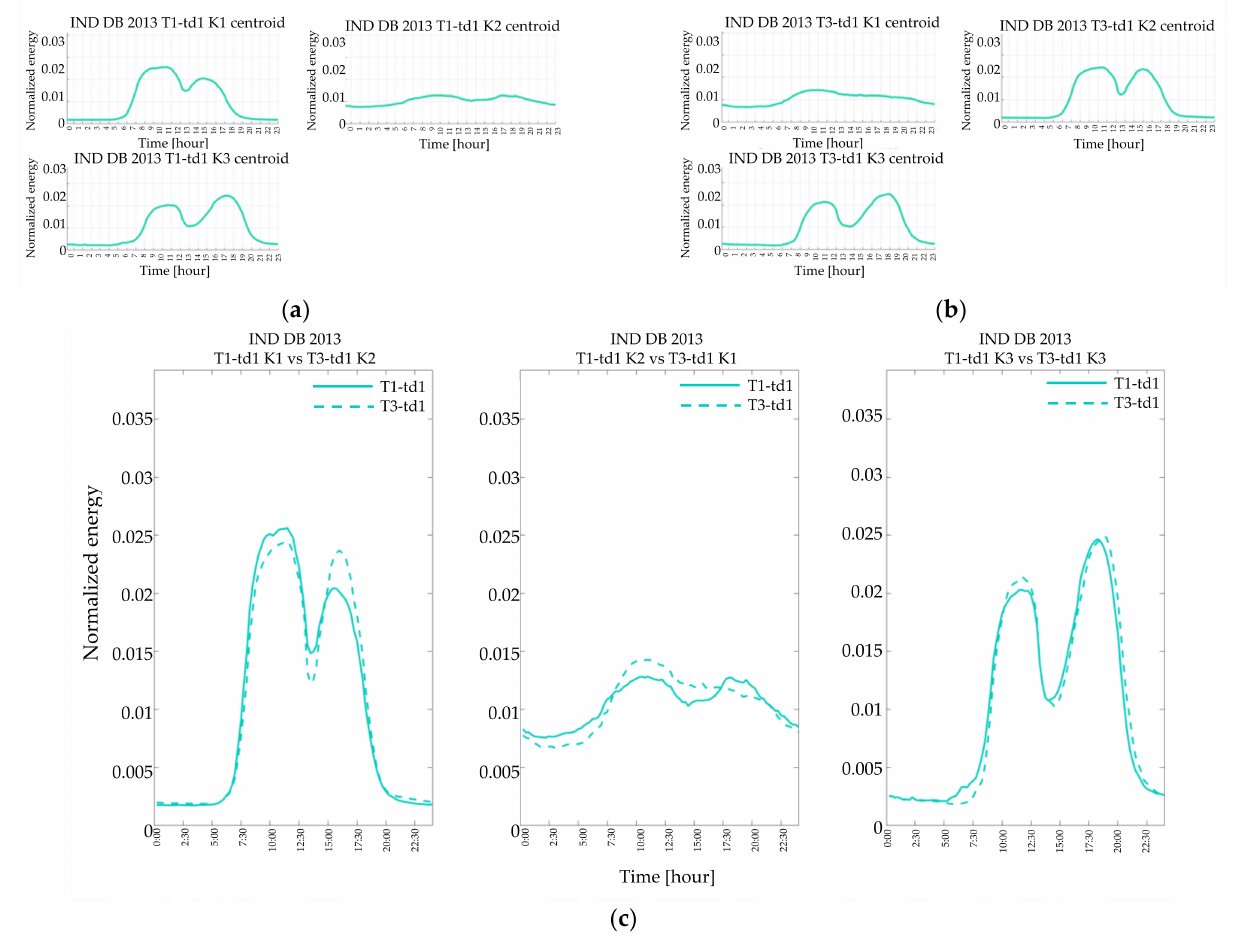
Figure 11. Database 2013, industrial (IND) end-users, normalized centroids: ( a ) winter workdays (three clusters), ( b ) summer workdays (three clusters), ( c ) comparison between the two typical